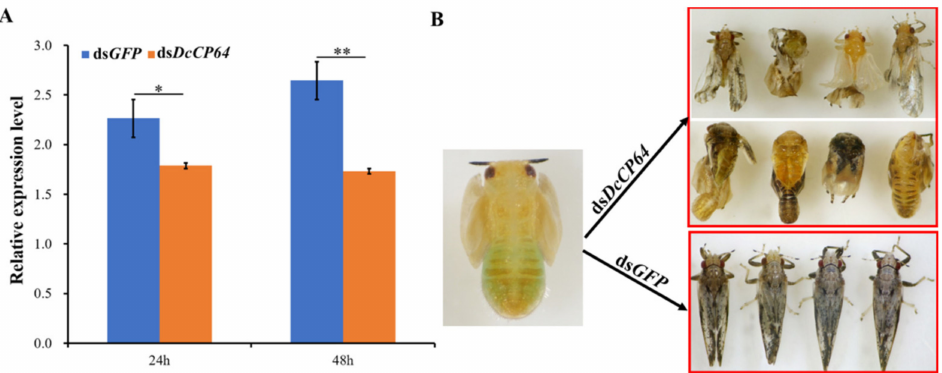
Figure 4. Effects on D. citri after RNA interference (RNAi) of DcCP64 . ( A ) Relative expression levels of DcCP64 when D. citri was treated with ds DcCP64 and ds GFP . The mean expression level represented for three biological replicates. The relative expression levels were calculated using the 2 − ∆∆ Ct method. Statistical analysis was performed using SPSS software. The significant differences are indicated by